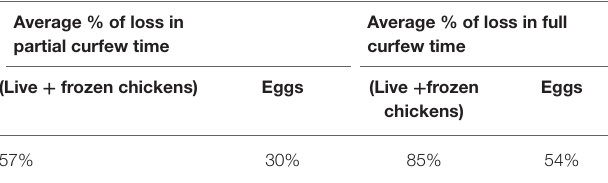
TABLE 7 | Average percentage loss in chicken and table-egg sales during partial and full